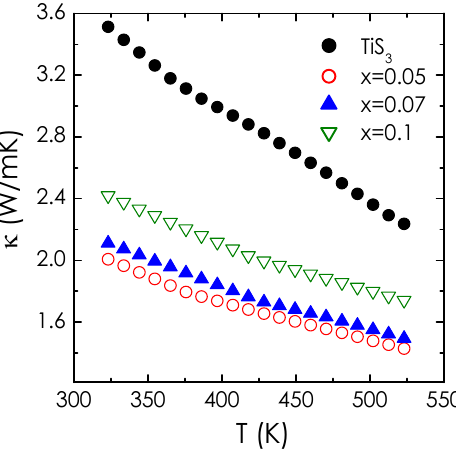
Figure 5. Temperature dependence of the thermal conductivity in the Ti 1 − x Nb x S 3